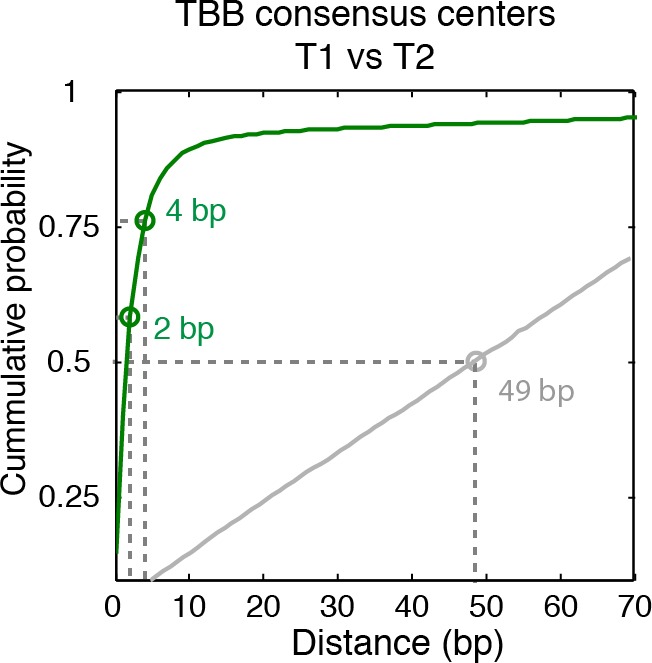
Cumulative distribution of the nearest distance analysis in Figure 2D.Green traces and gray traces show the cumulative distribution of the nearest distance between between the TBB consensus centers (green) or randomly generated consensus centers (gray) mapped in two independent experiments. Circles mark the distance that matches 50% and 75% in the cumulative probability distribution.